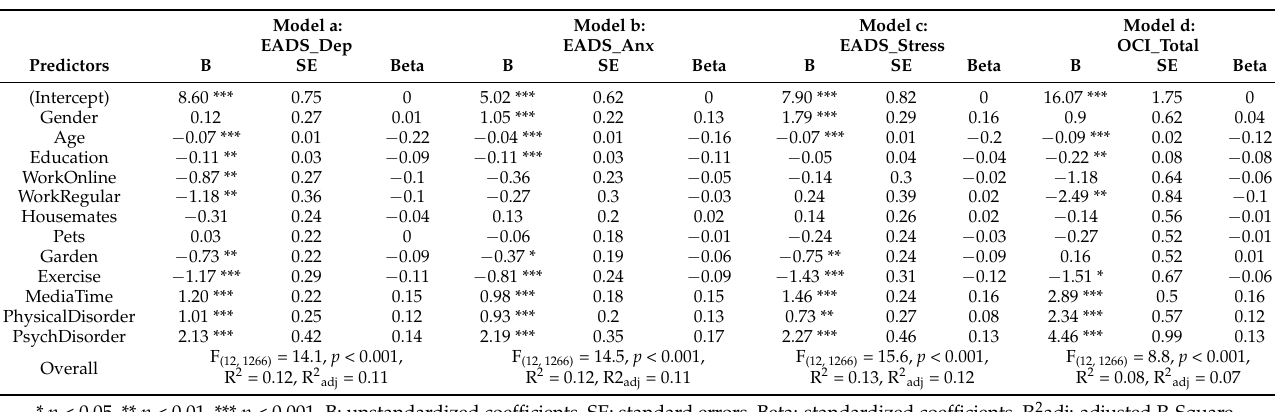
Table 3. Description of the regression models for the full sample.